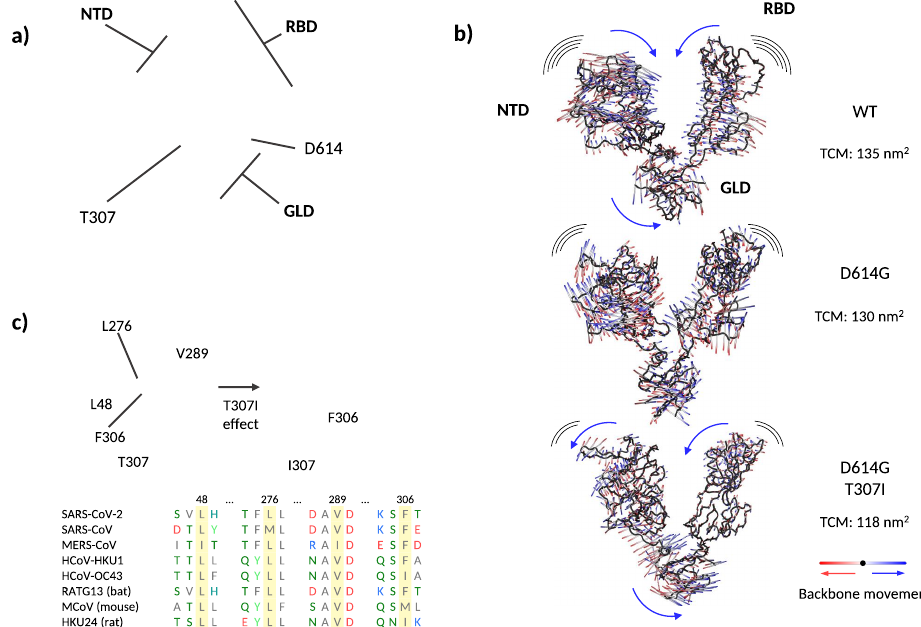
Figure 4. Structure and dynamics of the soluble part of SARS-CoV-2 spike. ( a ) Global architecture of the homotrimer. The foremost protomer is shown in cartoon representation, while the other two are shown by solvent accessible surface. The S1 segment is colored by structural domains discussed in the main text (green: N-terminal domain, NTD; red: receptor binding domain, RBD; blue: gear-like domain, GLD). The two amino acids mutated are shown in space-filling representation and the amino acids in the furin loop are shown as sticks. ( b ) Extreme projections of the main component of the motion in the S1 segment. The black tube corresponds to the average position of the protein backbone. The direction of the motion is indicated by lines changing from red to blue color. ( c ) Upper left panel: close up on the amino acids surrounding T307 and F306 in the cryo–electron microscopy structure used as the starting configuration. Upper right panel: Final conformation of the molecular dynamics simulation with the side chains of I307 and F306 in close contact. Lower panel: spike protein alignment around the conserved hydrophobic cluster (L48, L276, V289) interacting with F306 in different β